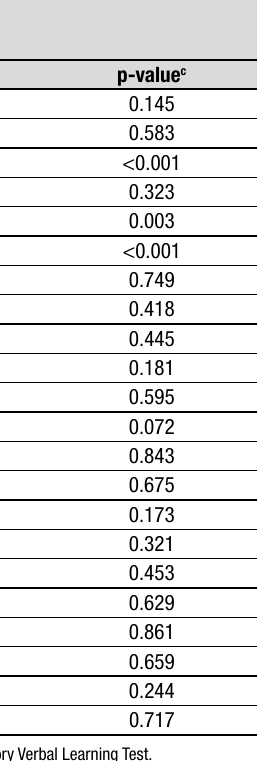
Table 1. Demographic information and neuropsychological test scores in a sample of cognitively normal elderly with subjective cognitive decline (SCD group) and without subjective cognitive decline (control group) submitted to final Brazilian version of Cognitive Function Instrument validation. Values expressed as median and interquartile range.